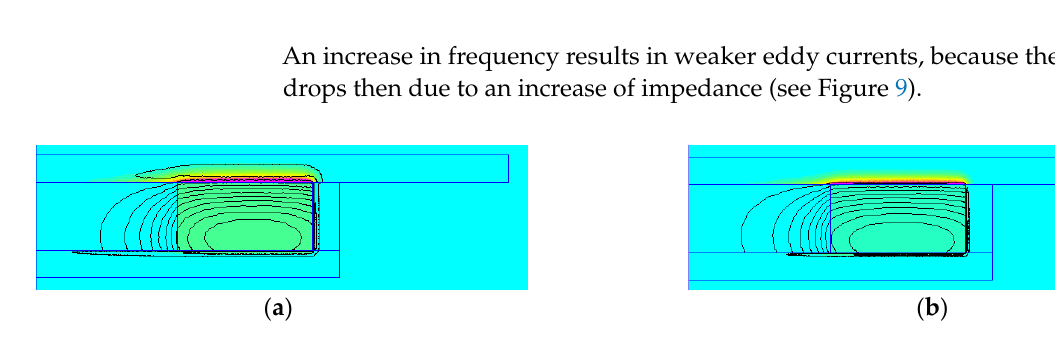
Figure 8. Localization of eddy-currents for a frequency of 40 kHz ( a ) and 70 kHz ( b ); the color scale is the same for both cases, half of the cross-section is shown.